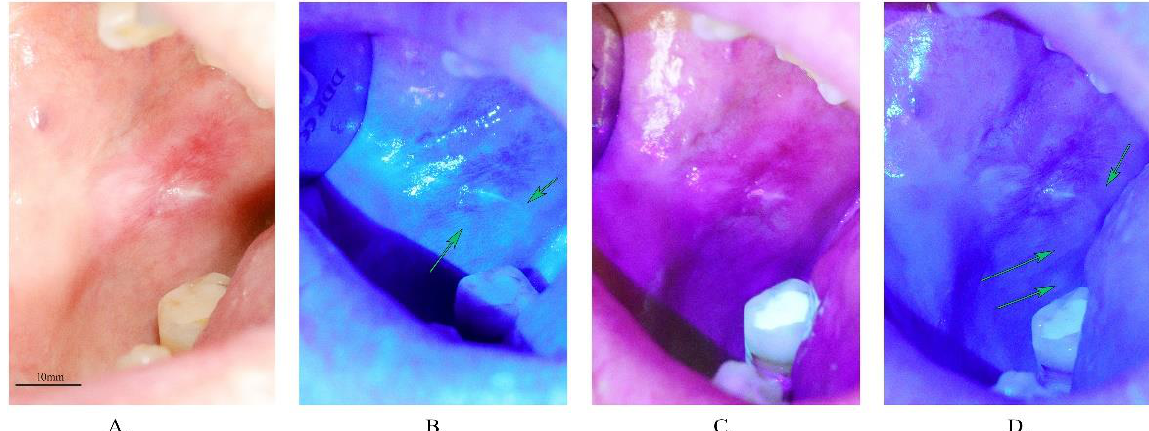
Figure 4. Examples of photographs taken in various wavelengths. ( A )—white light—full spectrum, ( B )—blue light (450 nm), ( C )—violet light (405 nm), ( D )—blue and violet light together (405 + 450 nm). Green arrows indicate thin hyperkeratinized areas (brighter sites) which are not able to be seen in the classical white light examination (scale bar 10 mm).